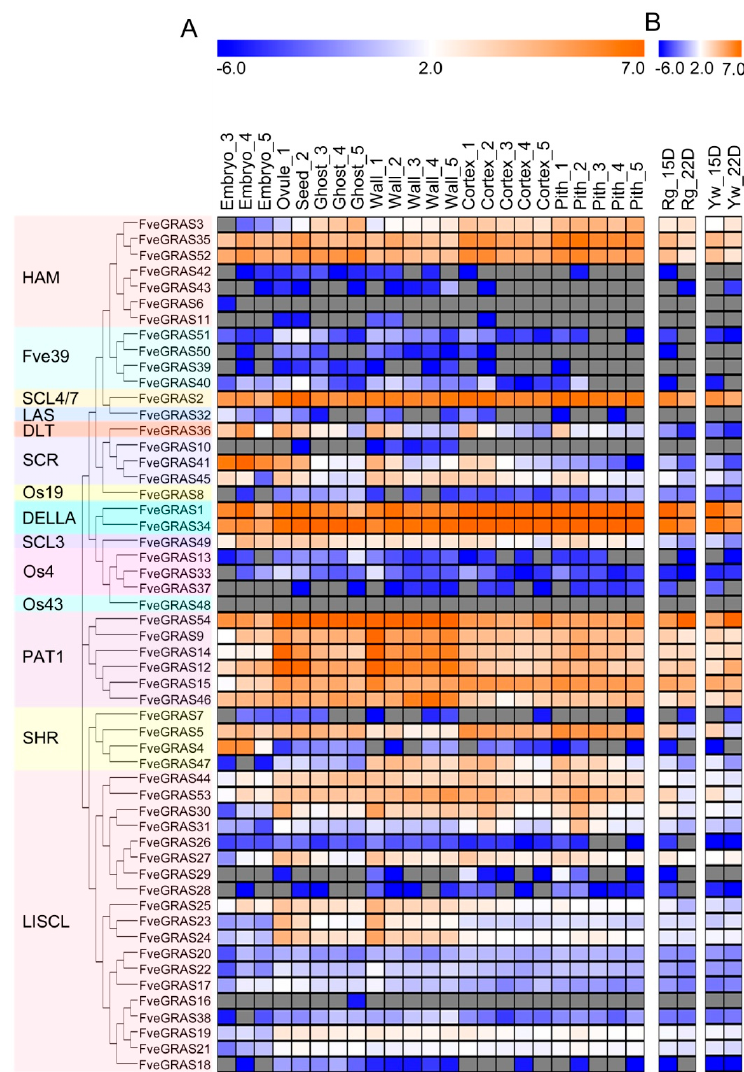
Figure 5. Expression pattern of GRAS genes in developing and ripening fruit tissues of woodland strawberry. ( A ) Expression pattern of GRAS genes in developing fruit tissues (including embryo, ovule, ghost, wall, cortex and pith). ( B ) Expression change of GRAS genes from immature to ripening fruits in two varieties “Ruegen” and “Yellow Wonder”. RPKM values in ( A , B ) downloaded from Li et al. (2019) [43] were in Supplementary Table S7 and S8, and the heat map showed log2 level. Numbers after tissues in ( A ) represent different developmental stages: Stage 1 (pre-fertilization), stage 2 (2–4 days post-anthesis (DPA)), stage 3 (6–9 DPA), stage 4 (8–10 DPA) and stage 5 (10–13 DPA). Rg and Yw in ( B ) represent “Ruegen” and “Yellow Wonder”, and 15D and 22D represent 15 and 22 DPA.